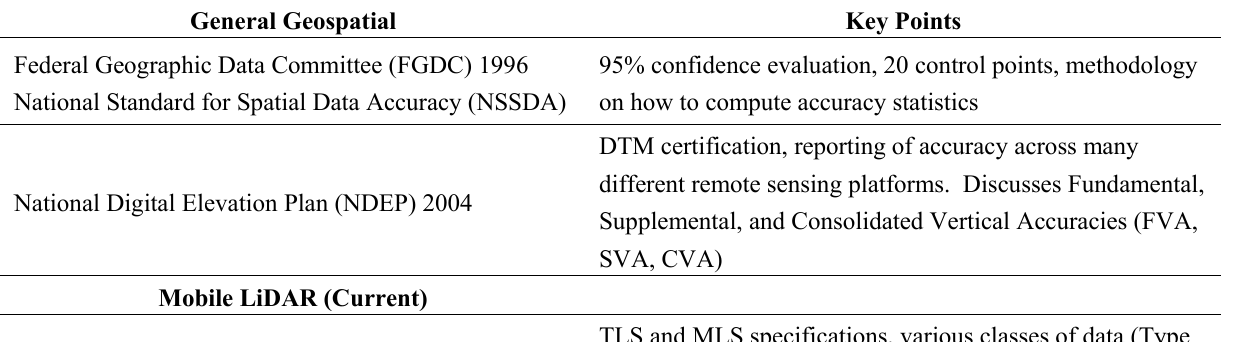
Table 1. Summary of existing LIDAR